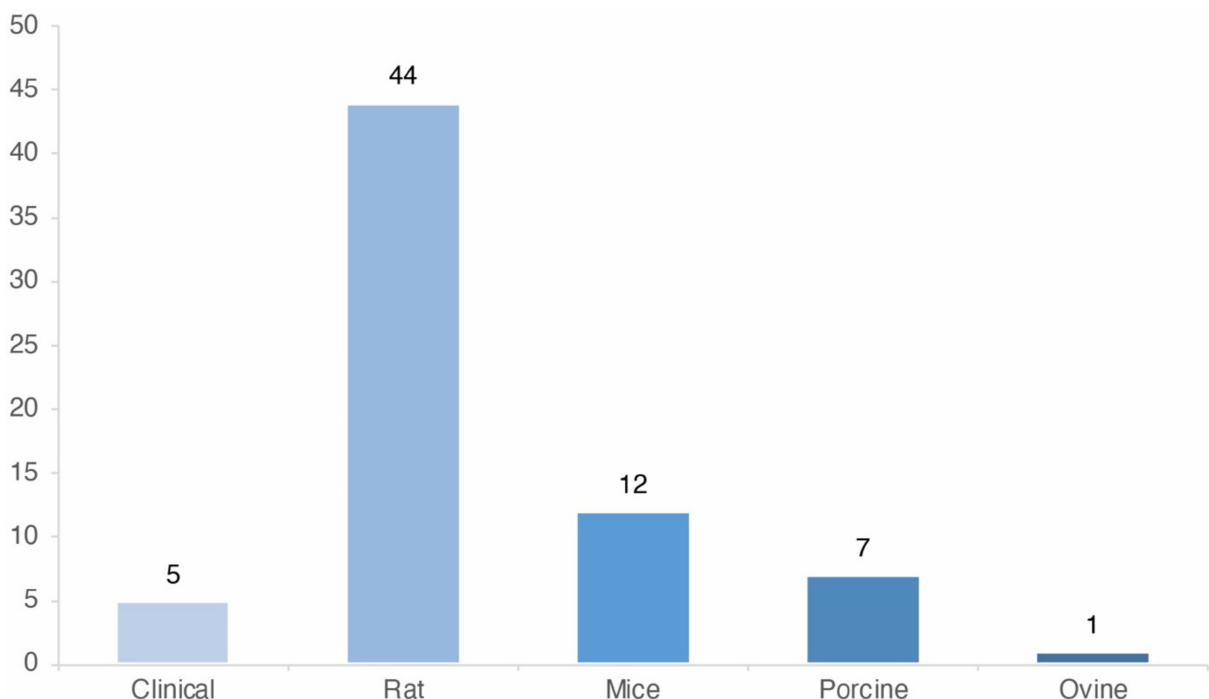
Figure 2. Study models used in included studies ( n =